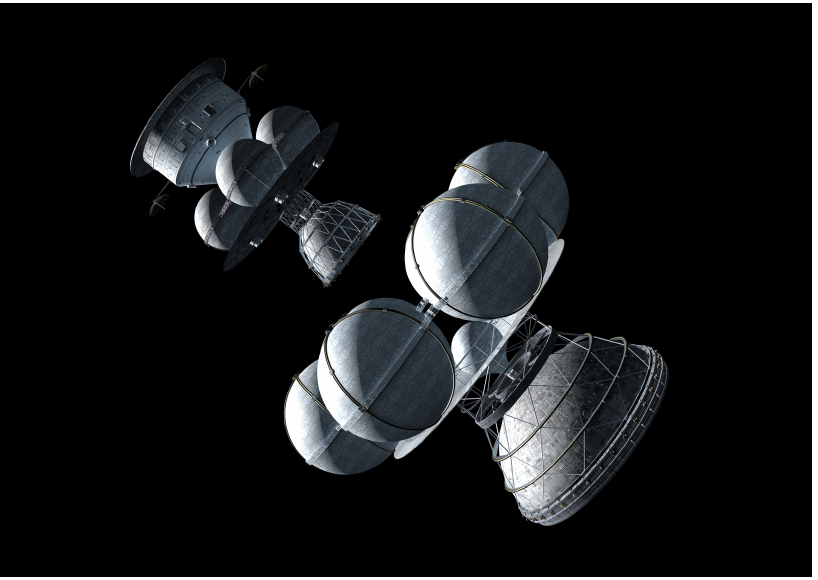
Figure 7. The Daedalus spacecraft concept